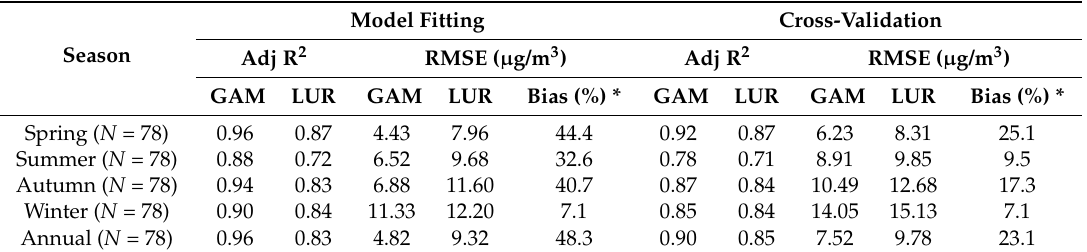
Table 3. Comparison of model fitting and cross-validation results for the GAM and LUR